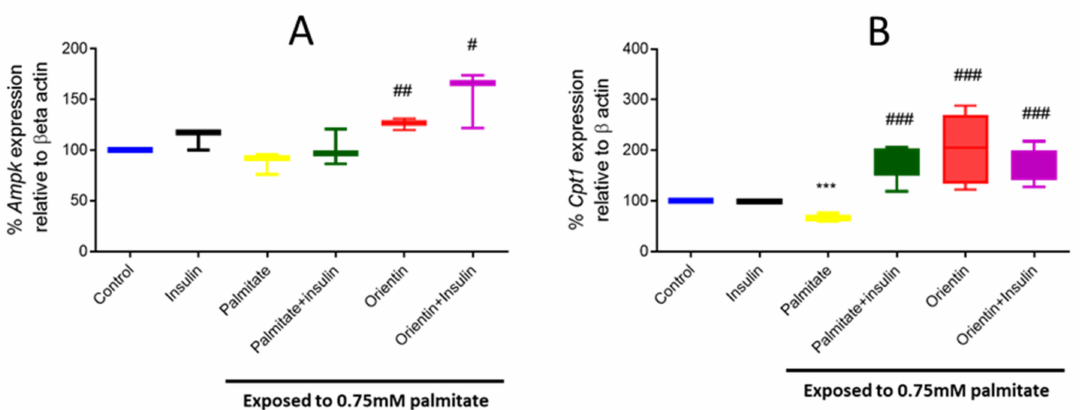
Figure 4. Effect of orientin on the expression of genes involved in energy metabolism, such as 5 (cid:48) adenosine monophosphate- activated protein kinase ( Ampk ) ( A ) and carnitine palmitoyl transferase 1 ( Cpt1 ) ( B ) in C3A liver cells exposed to high (0.75 mM) palmitate concentration. Briefly, insulin resistance was induced with 0.75 mM of palmitate for 16 h in C3A liver cells, followed by treatment with or without 10 µ M of orientin for 3 hrs and 1 µ M of insulin. This was then followed by investigating genes in energy metabolism using qPCR. Results are expressed as mean ± SD of 3 independent experiments. The bars depict statistical differences at *** p < 0.001, versus the experimental control set at 100% and # p < 0.05, ## p < 0.01, ### p < 0.001 versus palmitate